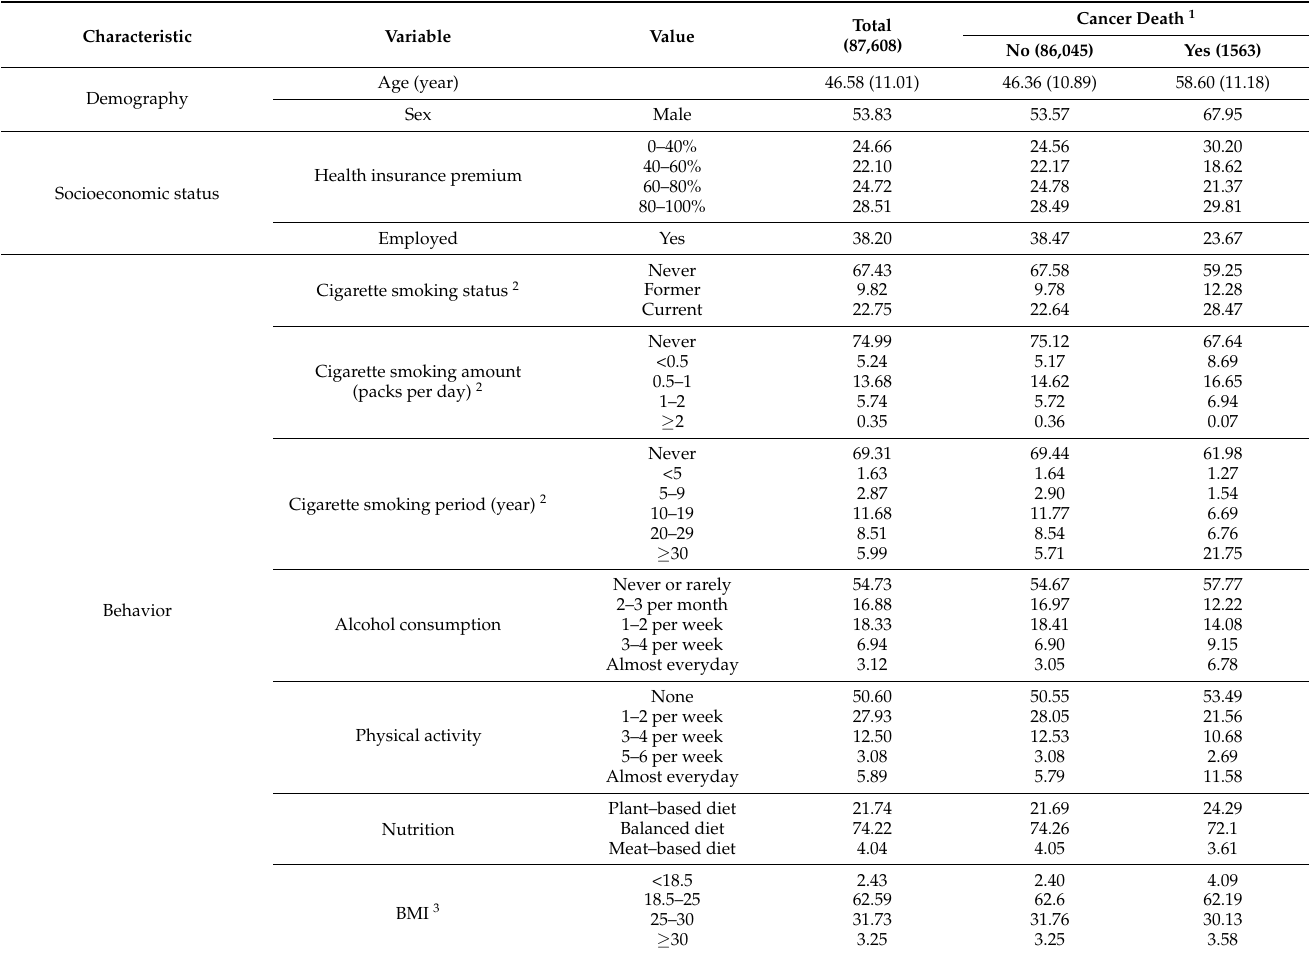
Table 1. Descriptive summary of individual and areal characteristics of 87,608 National Health Insurance Service–National Sample Cohort subjects and by their cancer death status in the Seoul Metropolitan Area (SMA) for